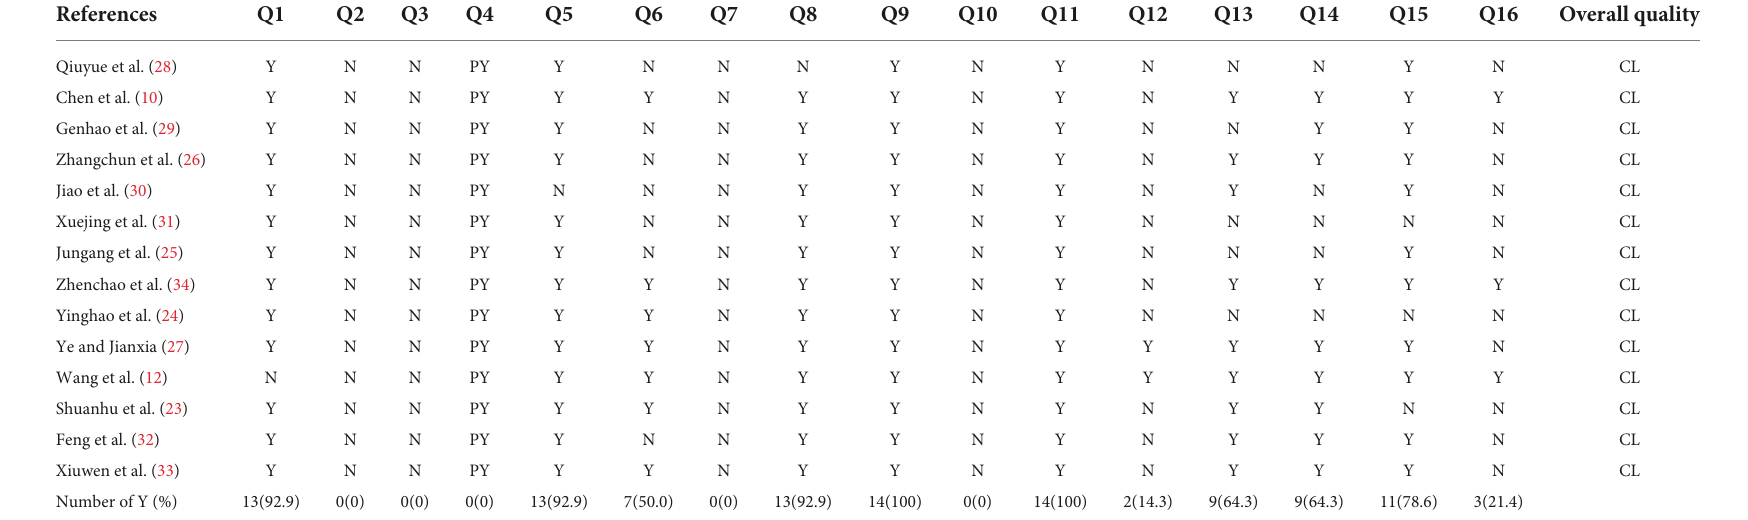
TABLE 3 Methodological quality assessment of the included reviews using the AMSTAR 2